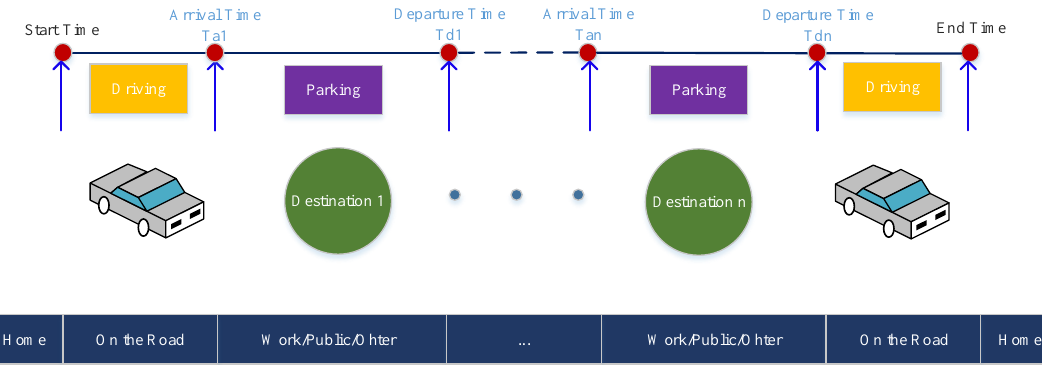
Figure 1. The typical daily movement of PEVs based on trip chain.